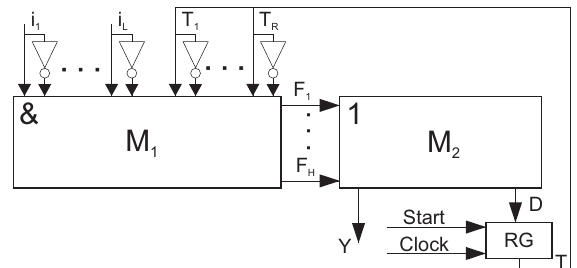
Figure 9. Trivial matrix implementation of P Mealy